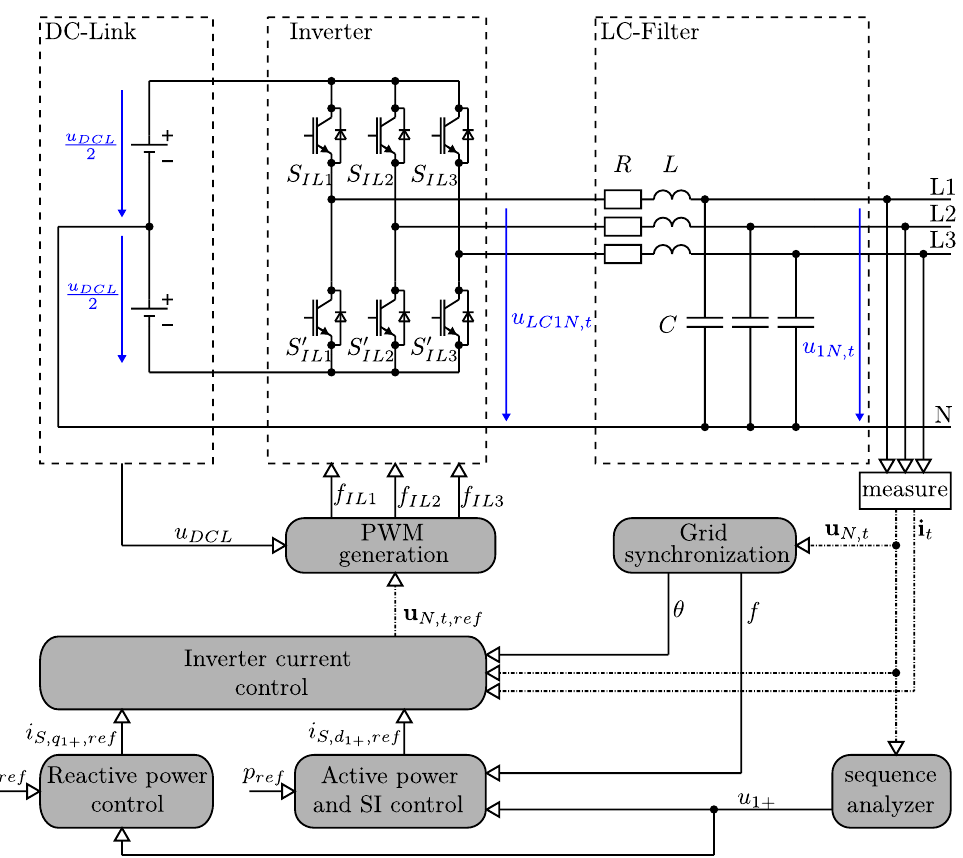
Figure 4. Model of a converter and its control, which is capable of providing passive synthetic inertia. The figure also shows relevant voltages which are marked in